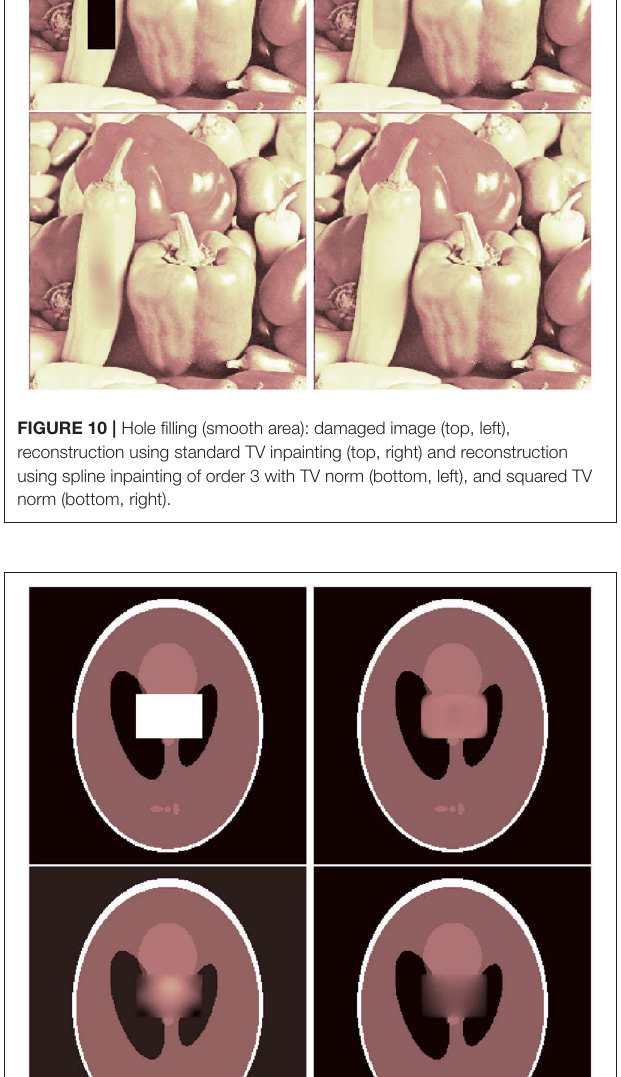
FIGURE 11 | Hole filling (including edges): damaged image (top, left), reconstruction using standard TV inpainting (top, right) and reconstruction using spline inpainting of order 4 with TV norm (bottom, left), and squared TV norm (bottom,